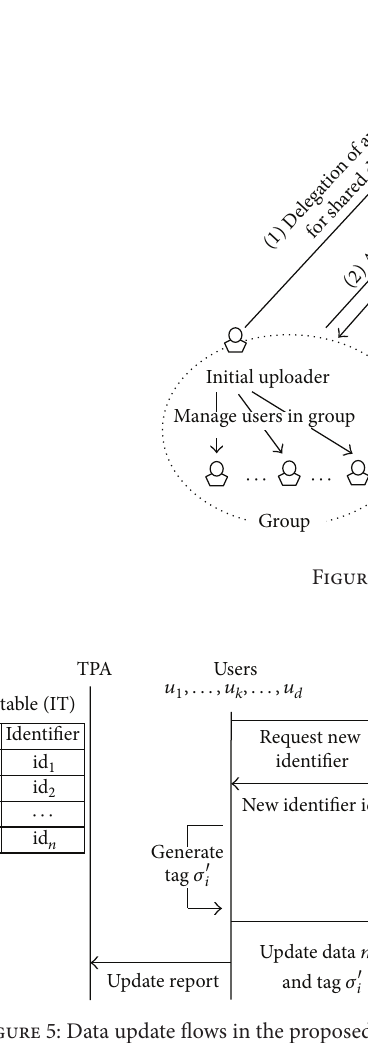
Figure 5: Data update flows in the proposed